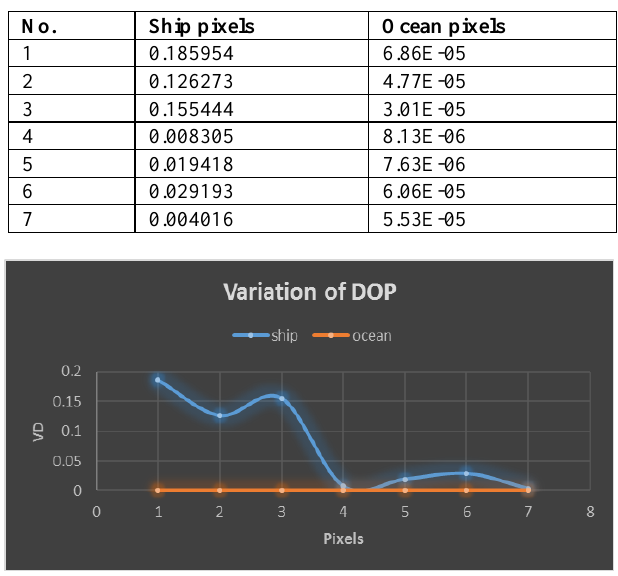
Fig. 15 Variation of DOP Analysis of UAVSAR Ship and ocean pixels The Variation of DOP (VD) shows the separation between ocean and ship pixels, and the details are mentioned in table 11, and figure 15